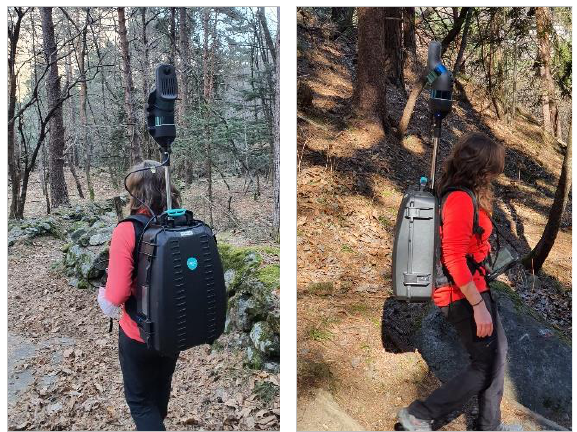
Figure 3. Backpack LS IMMS Heron MS Twin Color produced by Gexcel.